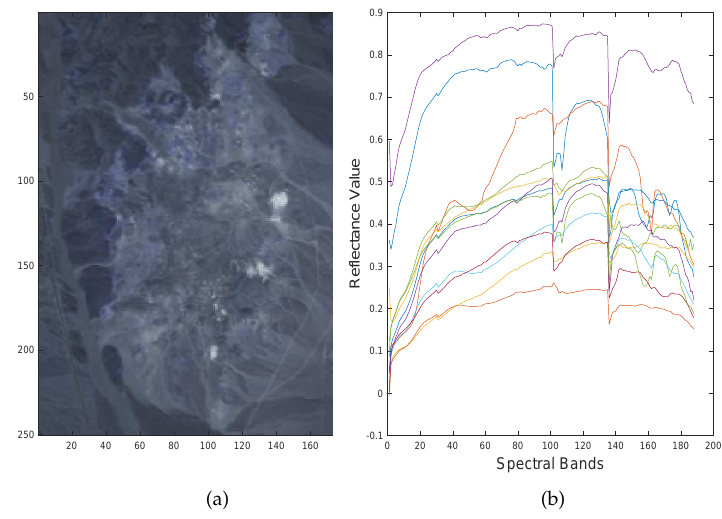
Figure 8. AVIRIS Cuprite data (denoted by S 7 ) used in the experiment. ( a ) The false color image illustrated with bands { 30,40,80 } of the sub-image of the AVIRIS Cuprite data set. ( b ) Twelve endmembers used for unmixing.